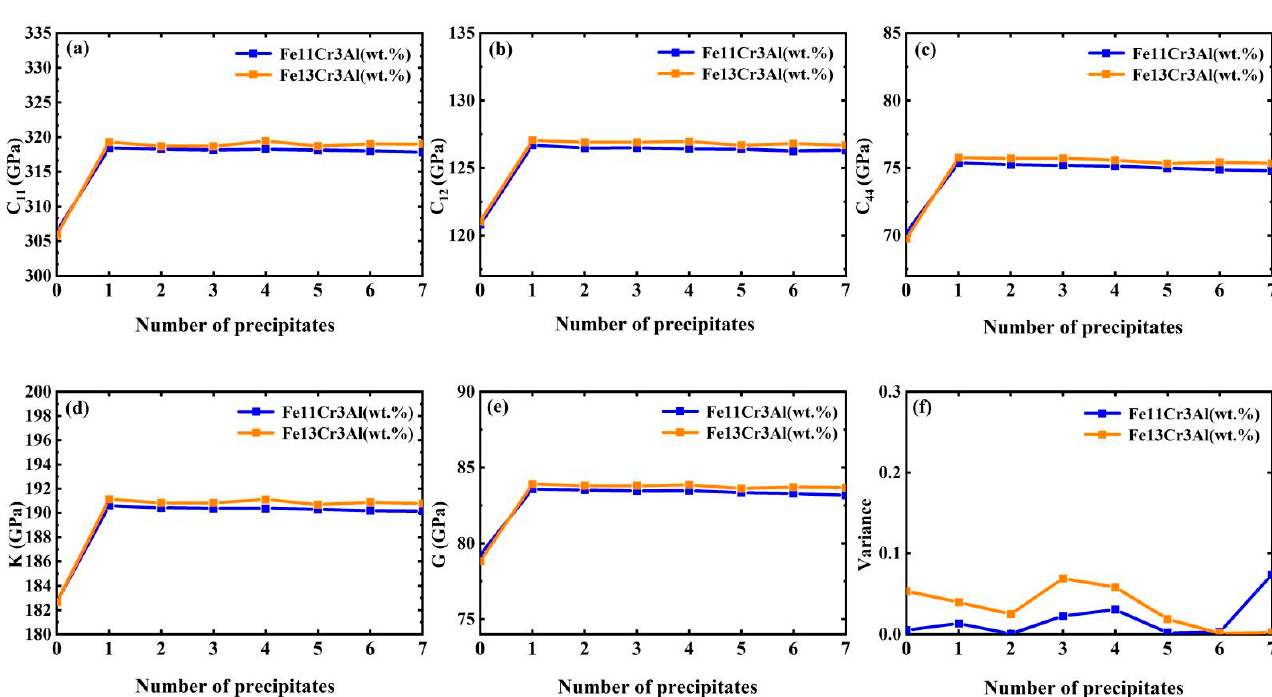
Figure 7 . ( a – e ) The dependence of C 11 , C 12 , C 44 , bulk modulus and shear modulus on number of Cr precipitates. ( f ) Example of statistical uncertainty for these elastic constants based on 50 simulations at 0 K.